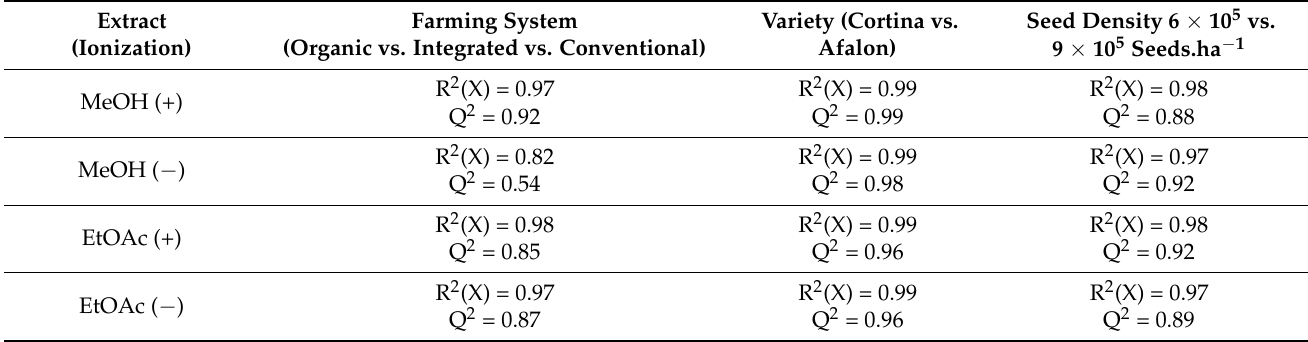
Table 1. An overview of the performance parameters of the OPLS-DA